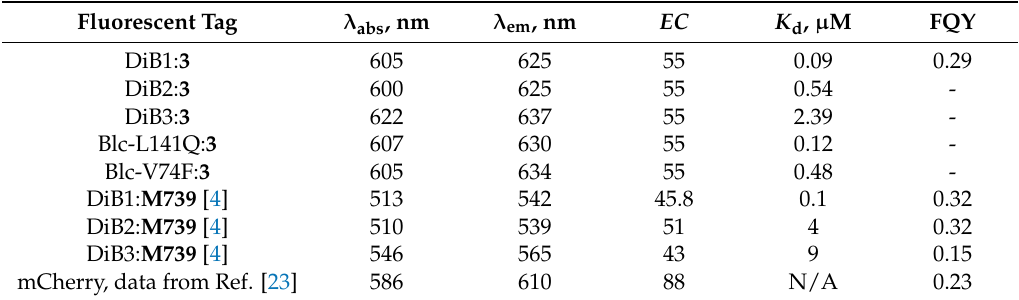
Table 1. Photophysical properties of the protein–fluorogen bipartite